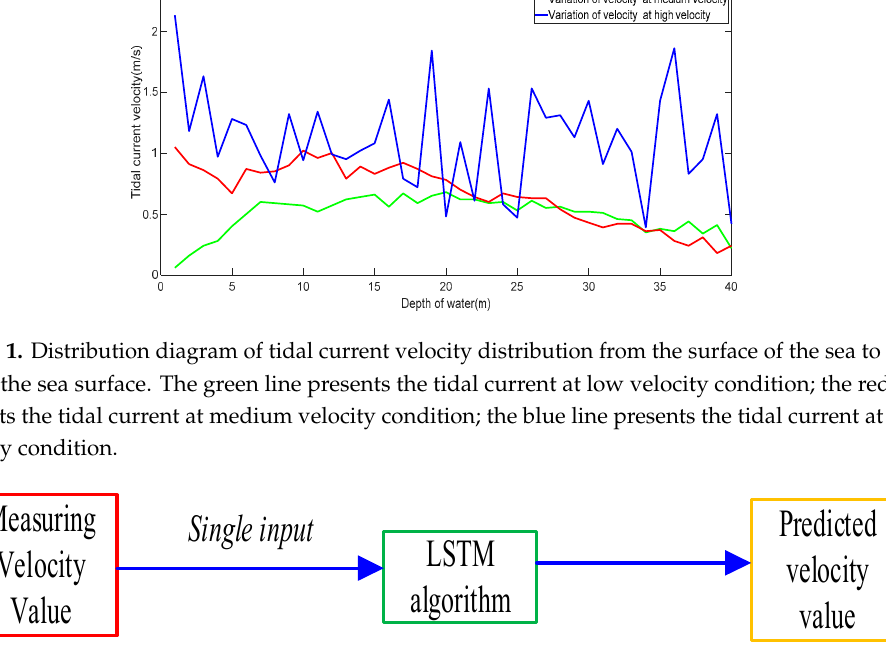
Figure 3. Diagram of a novel tidal current prediction considering the effect of the multi-layer current velocity method.